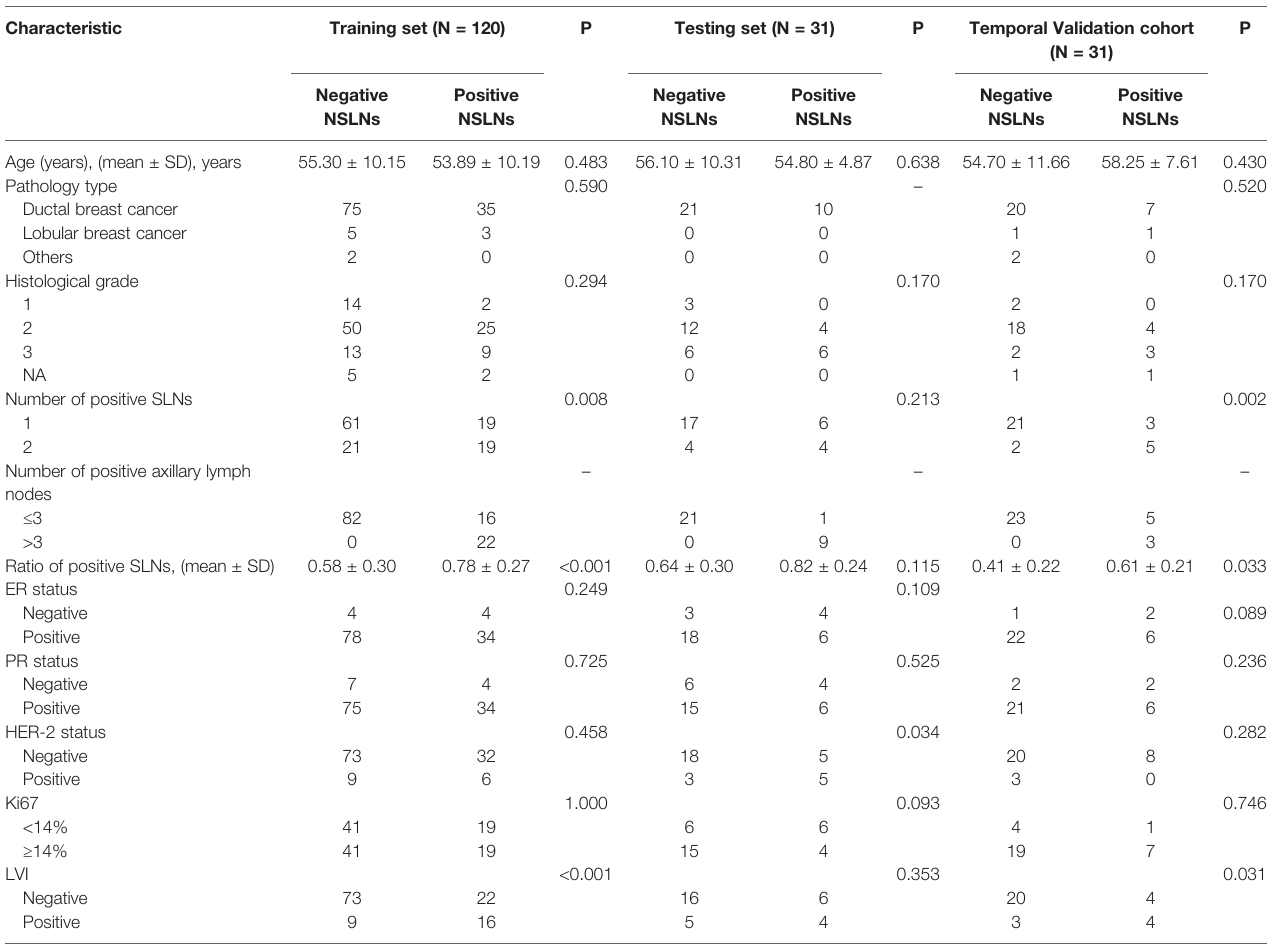
TABLE 1 | Patients ’ clinical characteristics.